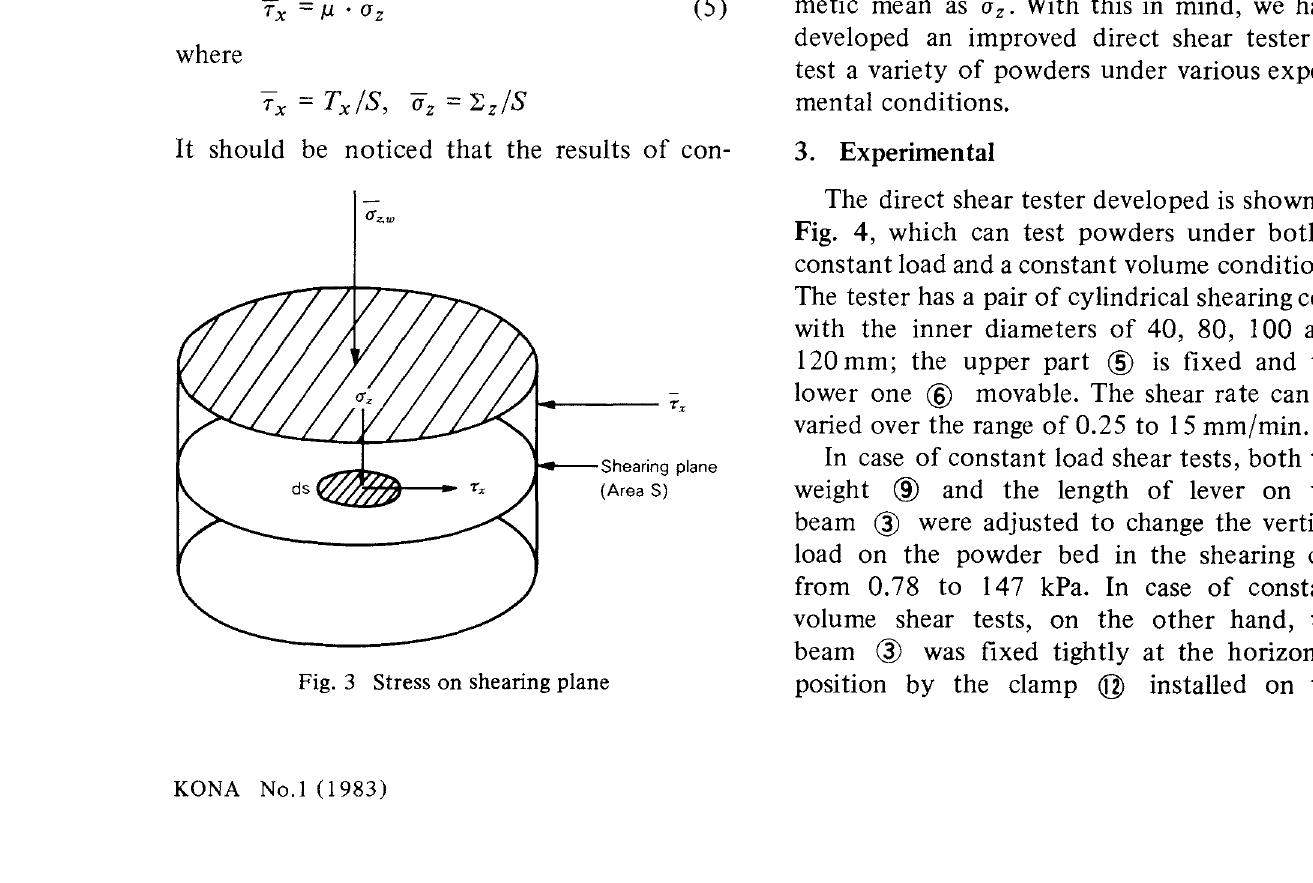
Fig. 3 Stress on shearing